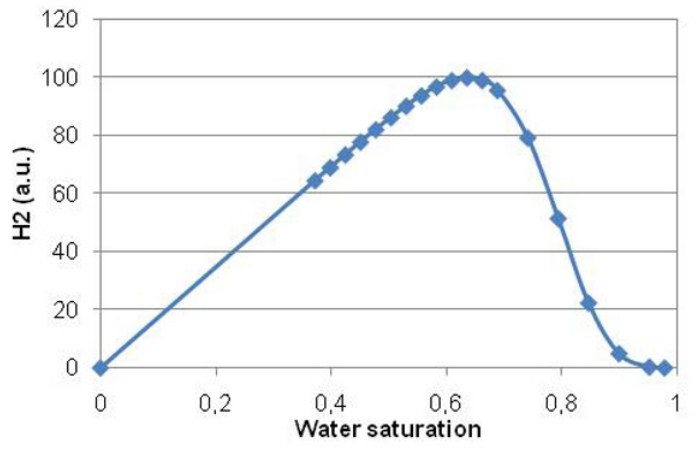
Fig. 2. Dihydrogen production over 100 years as a function of saturation